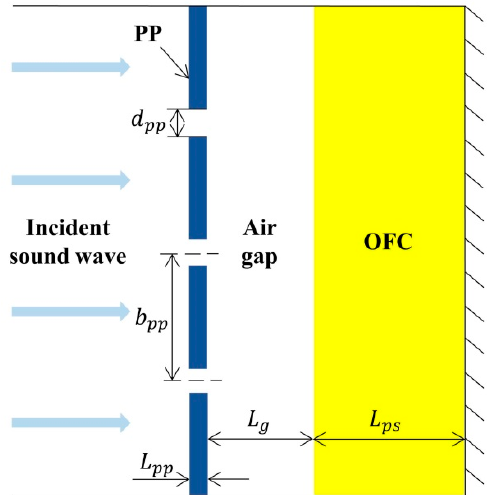
Figure 1. Schematic diagrams of composite sound-absorber structure.